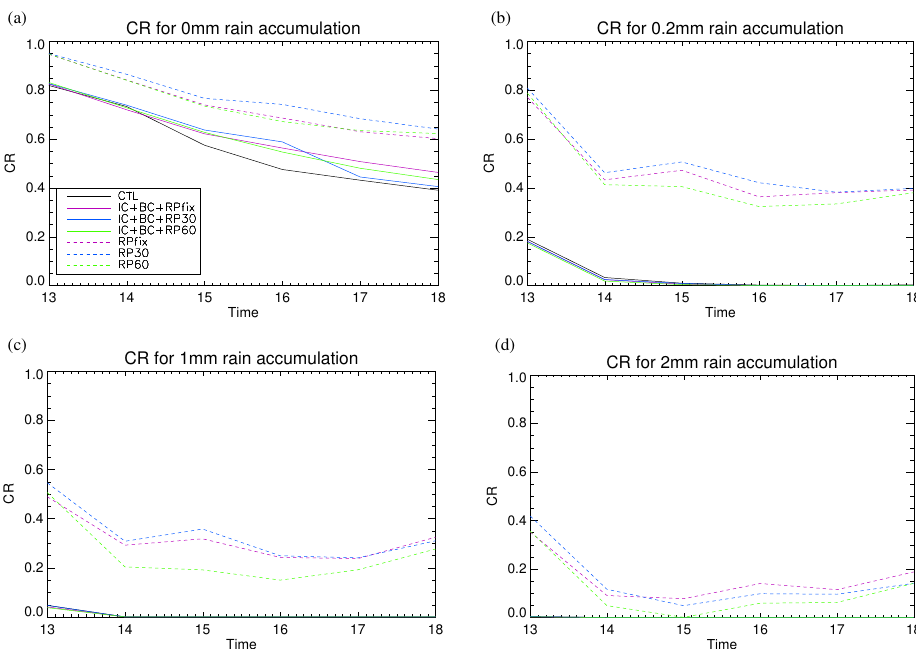
Fig. 15. Correspondence ratio for hourly rain accumulation for all the ensembles. Thresholds are (a) 0mm, (b) 0.2mm, (c) 1mm and (d)